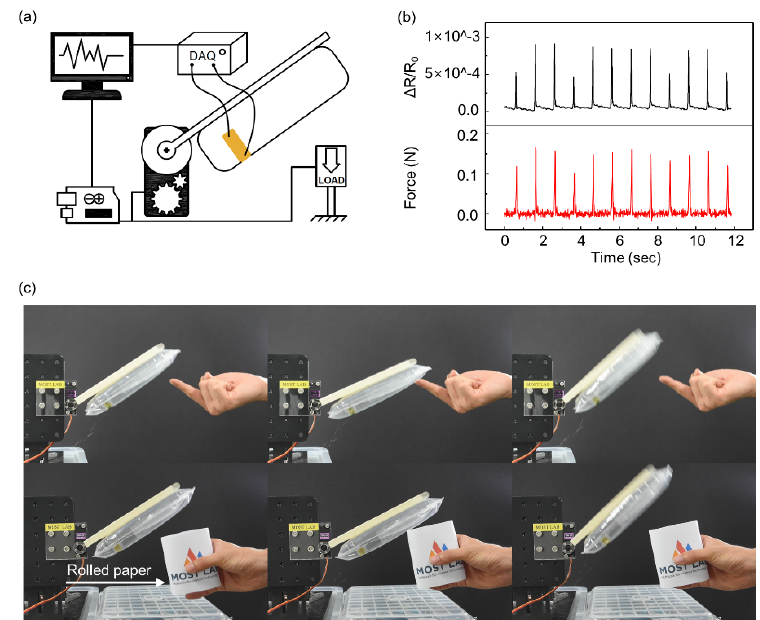
Figure 7. ( a ) Schematic illustration of the experimental setup for the simple robotic arm integrated with the balloon sensor. ( b ) Comparison between the applied force from the load cell (red line) and relative change in resistance (black line). ( c ) A simple robotic arm consisting of the balloon sensor and servo motor detecting gently touching fingers and a sheet of rolled paper. Yellow arrows indicate the movement direction of the balloon senor.